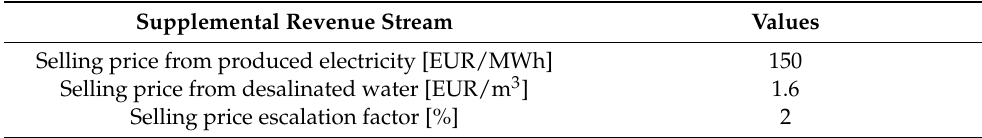
Table 9. The supplementary revenue stream.